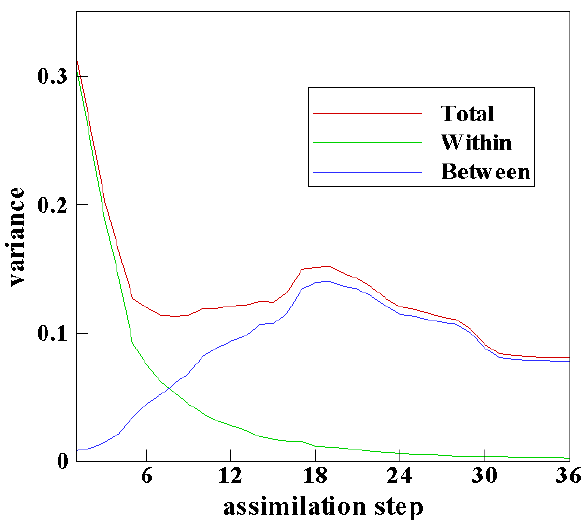
Figure 10. Dynamic changing of spatial averages of total multi-model ensemble variance, within-model variance, and between-model variance with